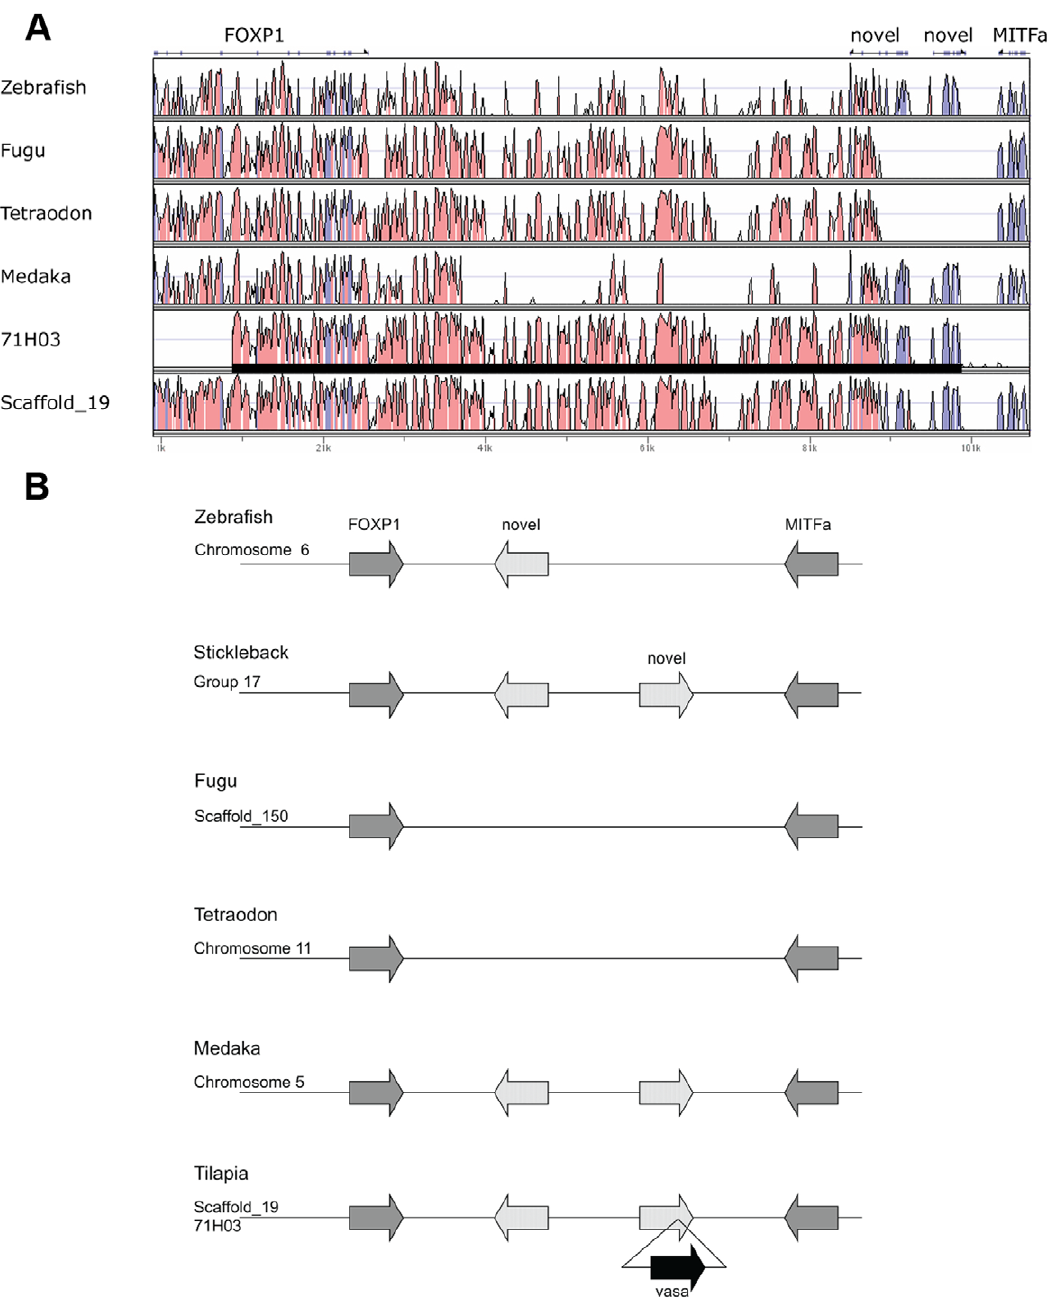
Figure 3. BAC clone 71H03 corresponds to a region between the FOXP1 and MITFa genes. (A) VISTA plots against stickleback show that 71H03 and Scaffold_19 correspond to a region between the FOXP1 and MITFa genes. Black bar indicates the region covered by BAC clone 71H03. Note that a vasa gene is not located in this region of other teleosts. (B) Genomic organization between the FOXP1 and MITFa genes of zebrafish, stickleback, fugu, Tetraodon , medaka and tilapia. The genomic organization is conserved in teleosts, except that two novel genes are predicted to be lineage-specific. The vasa gene copy on 71H03 was integrated into one of these novel genes.